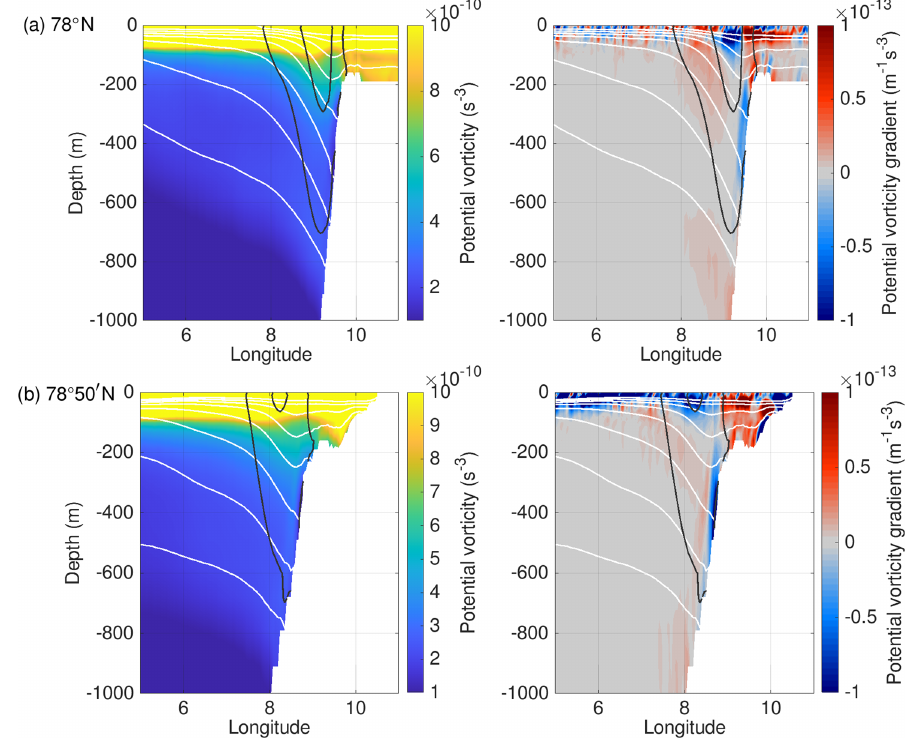
Figure 14. Ertel potential vorticity (left) and its gradient in the zonal direction (right) across Fram Strait at (a) 78 ◦ N and (b) 78 ◦ 50 (cid:48) N computed from long-term mean FESOM data (2006–2009). Black lines show simulated meridional velocity contours (0.1 and 0.2ms − 1 ), and white lines show the simulated 27.9, 28, 28.1, 28.2, and 28.22kgm − 3 isopycnals.